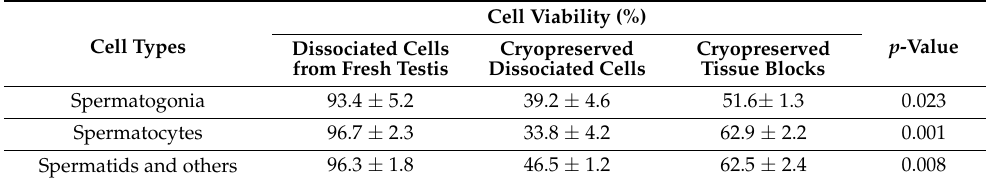
Table 1. The viability of testicular cells from the fresh and cryopreserved testes from 7-month- old shad.